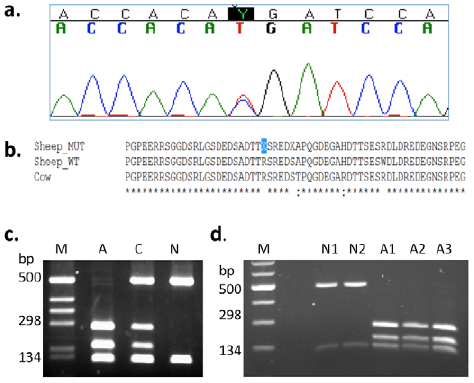
Figure 3. Mutation analyses. ( a ) The chromatogram shows the location of the mutation (Y: C/T). ( b ) Protein sequence alignments of DMP1. The highlighted R145X substitution induces a stop codon that leads to premature termination of the protein. MUT, R145X mutant; WT, wild type. ( c ) PCR-RFLP genotyping results for the affected (3 bands) and carrier (4 bands) Corriedale sheep and normal (2 bands) control sheep. M, 1kb marker; A, affected; C, carrier; N, normal. ( d ) RT-PCR-RFLP results for 2 controls (N1 &N2) and 3 affected sheep (A1, A2